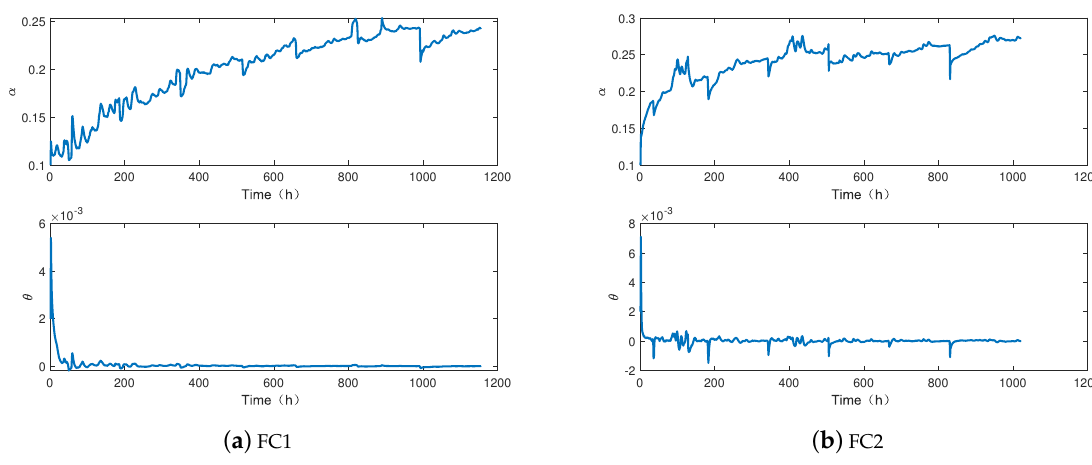
Figure 4. The results of state estimation.